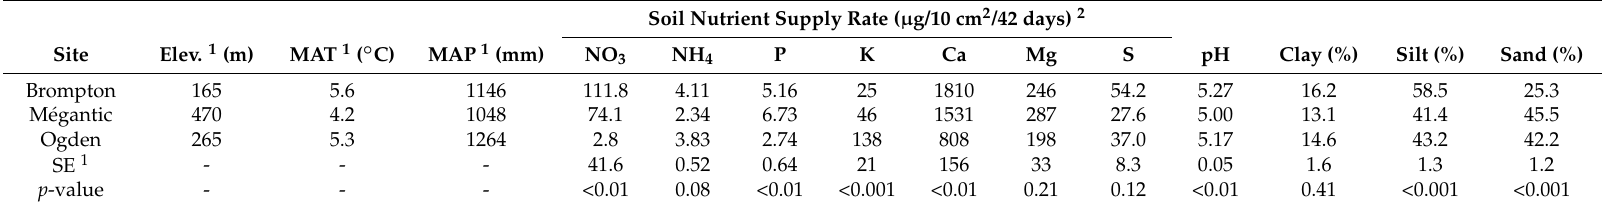
Table 1. Site and soil characteristics of the studied hybrid poplar plantations. Soil variables were measured during the 14th growing season